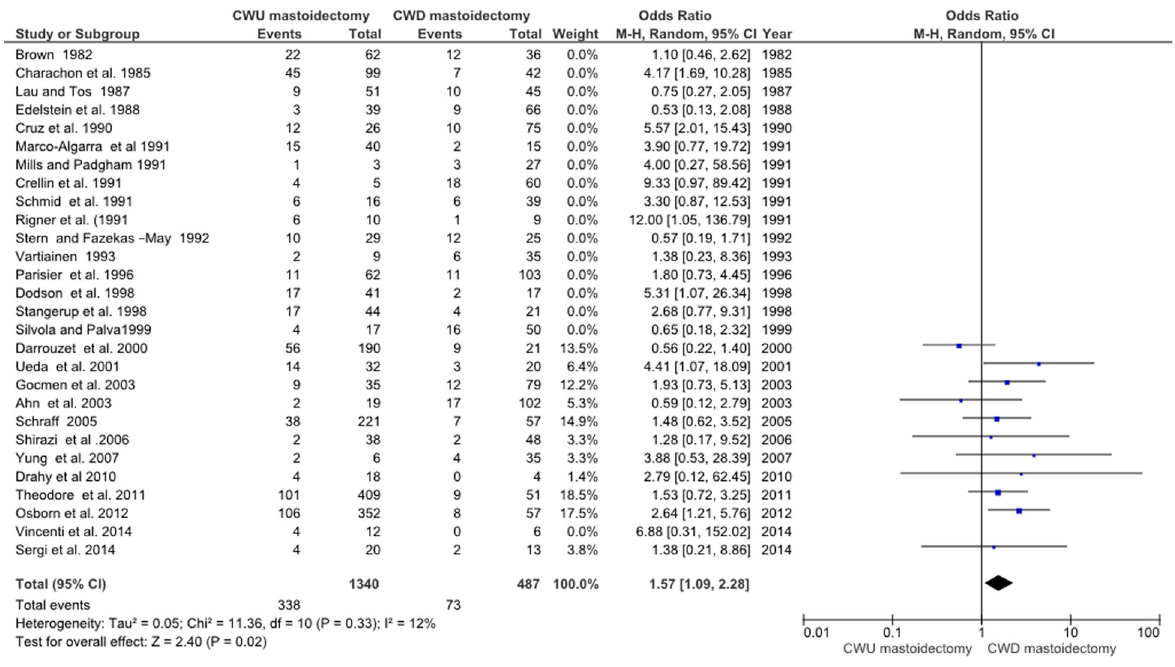
Fig. 6 Forest plot of analyzed data during and after the year